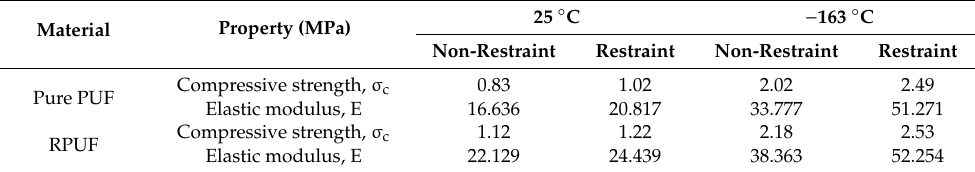
Figure 11. Dependences of the elastic modulus on restraint for ( a ) pure PUF and ( b ) RPUF. Table 6. Mechanical properties of pure PUF and RPUF specimens.